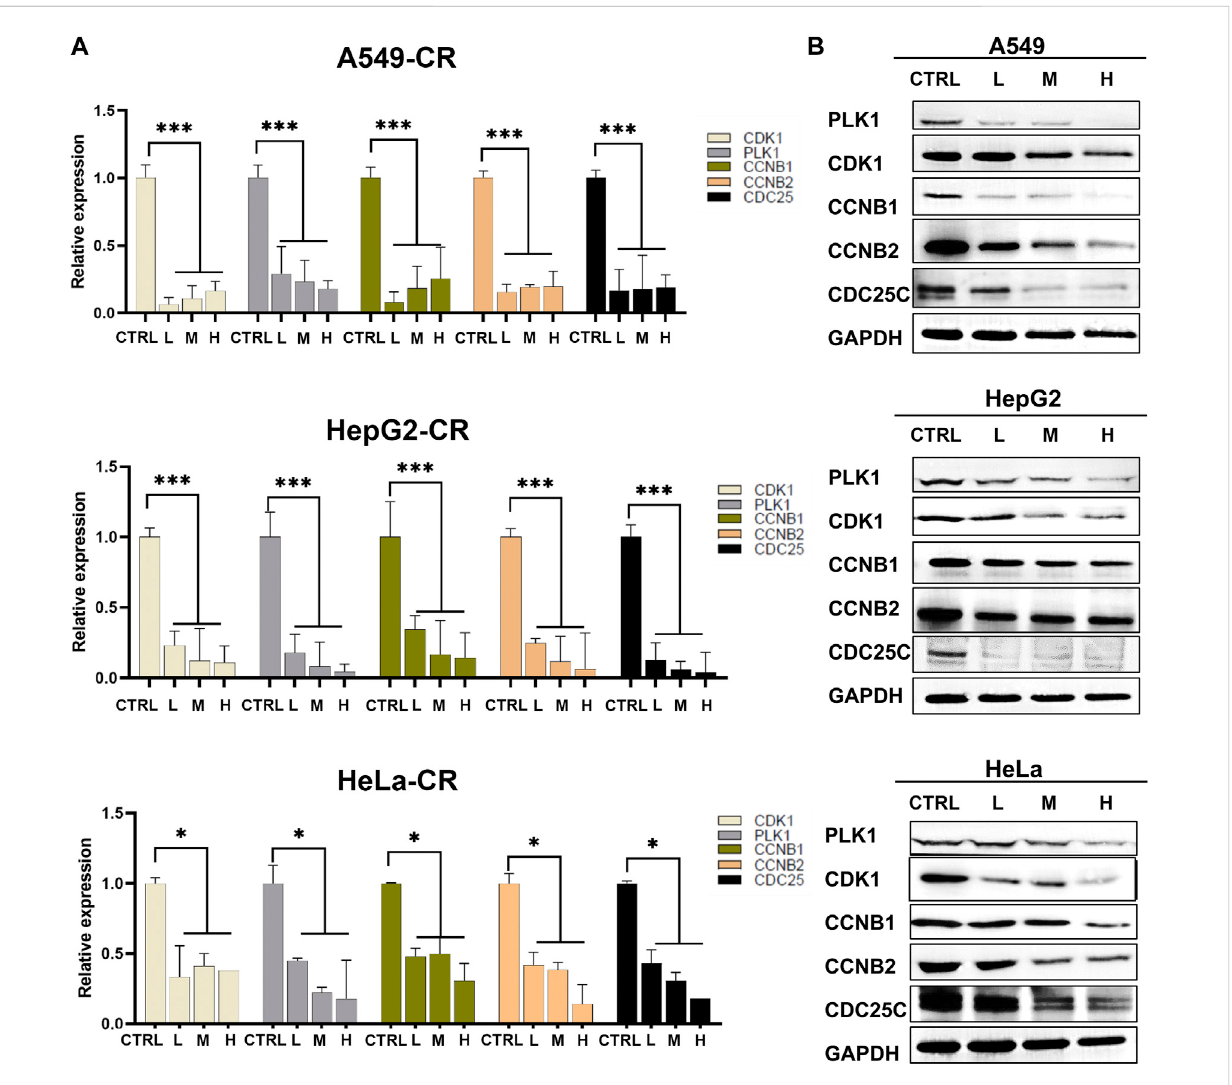
FIGURE 9 HubgenesexpressioninA549,HepG2,andHeLacelllinestreatedbyCR. (A) mRNAexpressionchangesofhubgenesafterCRtreatment. (B) Protein expression changes of hub genes after CR treatment. *, p < 0.05 vs. CTRL; **, p < 0.01 vs. CTRL; ***, p < 0.001 vs.